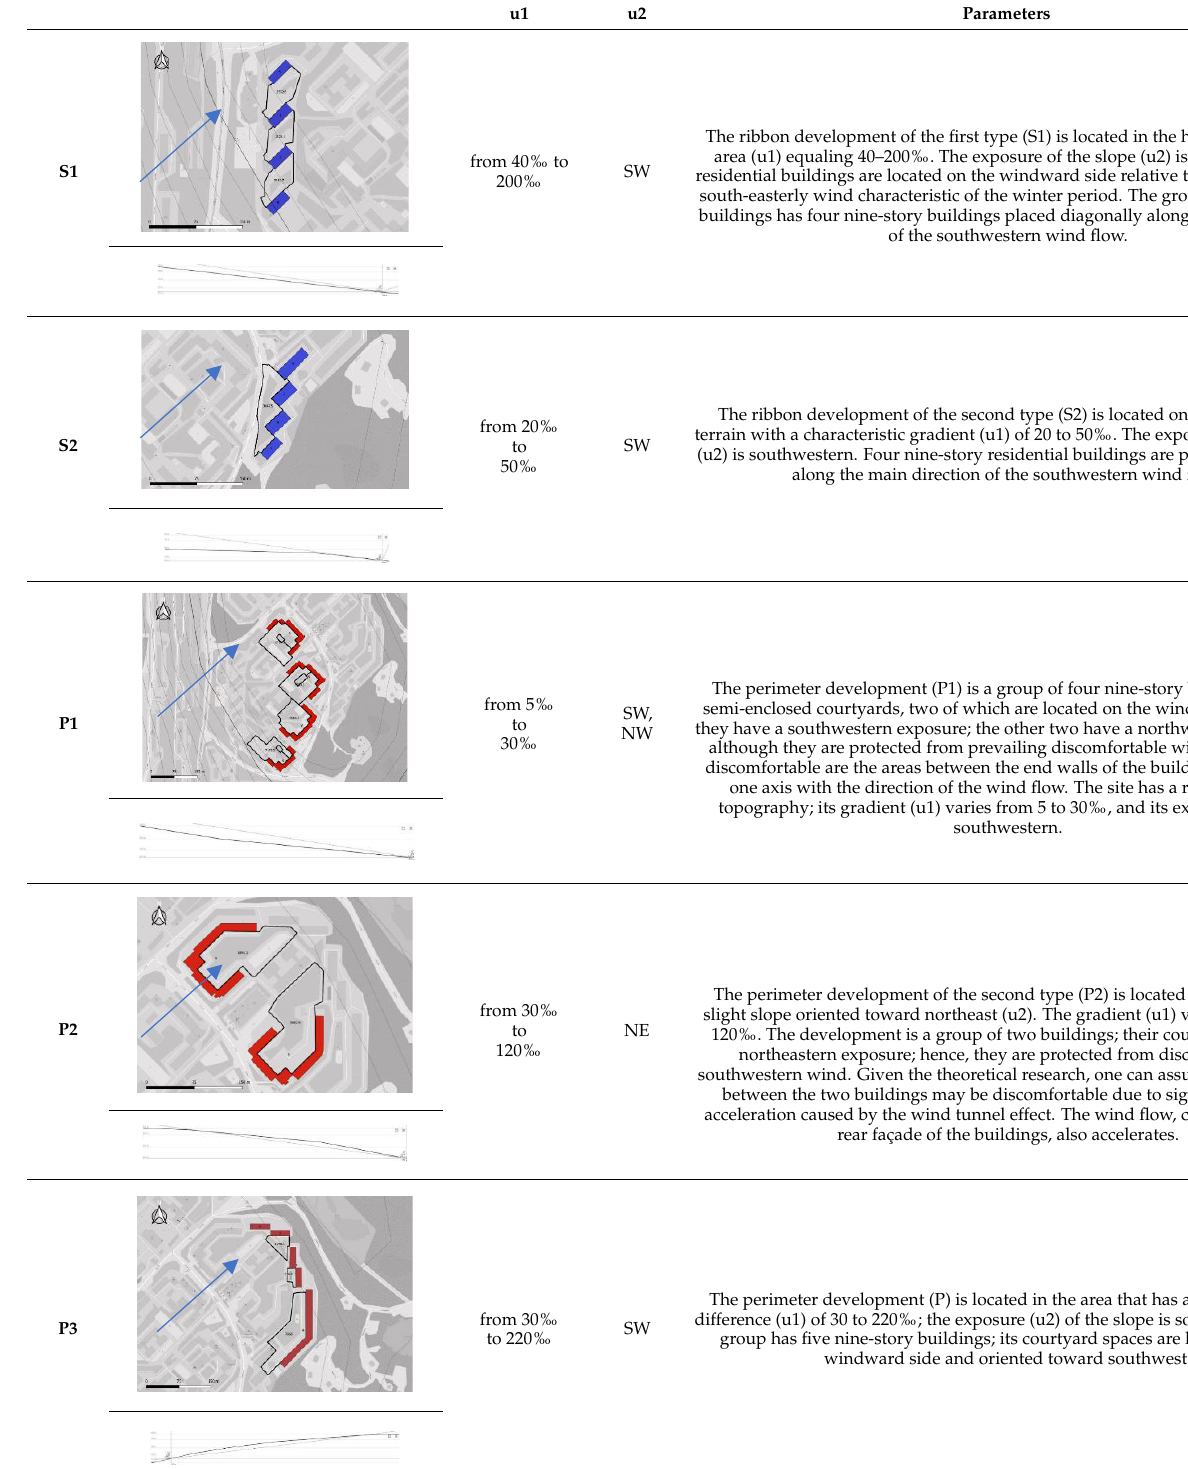
Table 7. Principal parameters of groups of residential buildings in question.